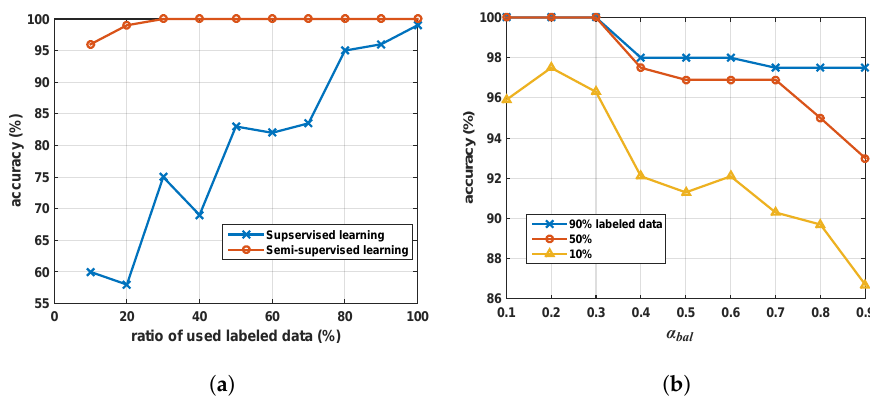
Figure 5. ( a ) Comparison of the supervised discriminant analysis and the semisupervised discriminant analysis for floor level estimation and ( b ) floor estimation accuracy with respect to the variation of α bal parameter values introduced in Equation (35) and the ratio of the labeled training data.